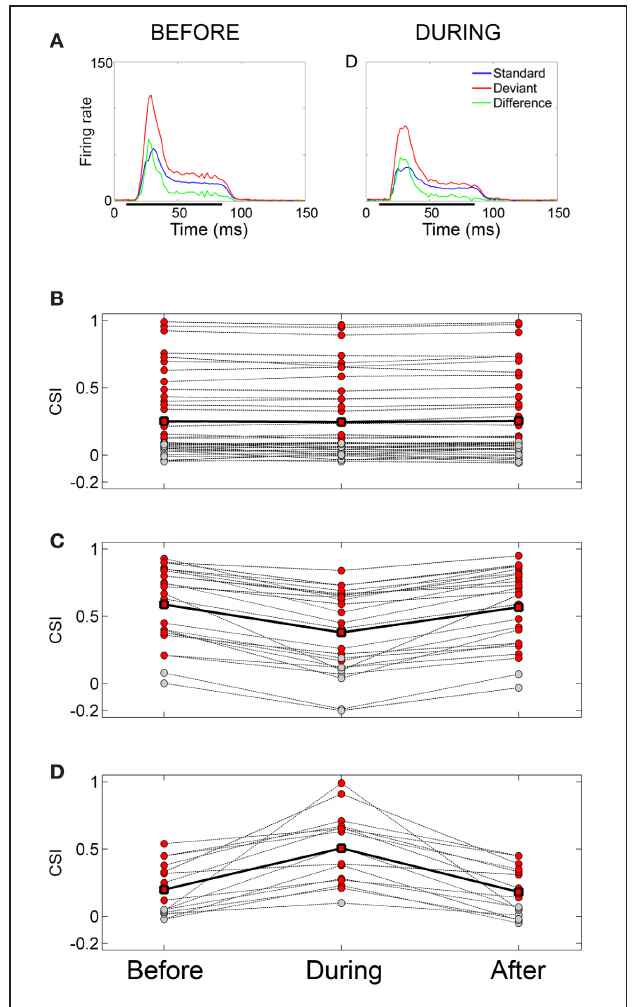
FIGURE 7 | Effect of cortical deactivation on SSA exhibited by IC neurons. (A) Mean population PSTHs from IC recordings ( n = 82) in response to tones presented as standard (blue) or deviant (red) before and during cooling the ipsilateral AC. The difference between the two is plotted in green. Deactivation of the auditory cortex does not eliminate the deviant saliciency in the averaged signal. (B) Population of neurons which showed no significant change in SSA during cooling, red circles indicate significant SSA, those in gray indicate non-significant CSI values. The solid line connected with square symbols indicates the mean CSI values for the three conditions. (C) Population which shows a decrease in SSA during cooling. Note that on cooling some neurons cease to show significant SSA. (D) Population which shows an increase in SSA during cooling. Note that on cooling some neurons which previously did not show significant SSA now become significant. Figure layout in (C) and (D) is the same as in (A) . Reproduced from Anderson and Malmierca